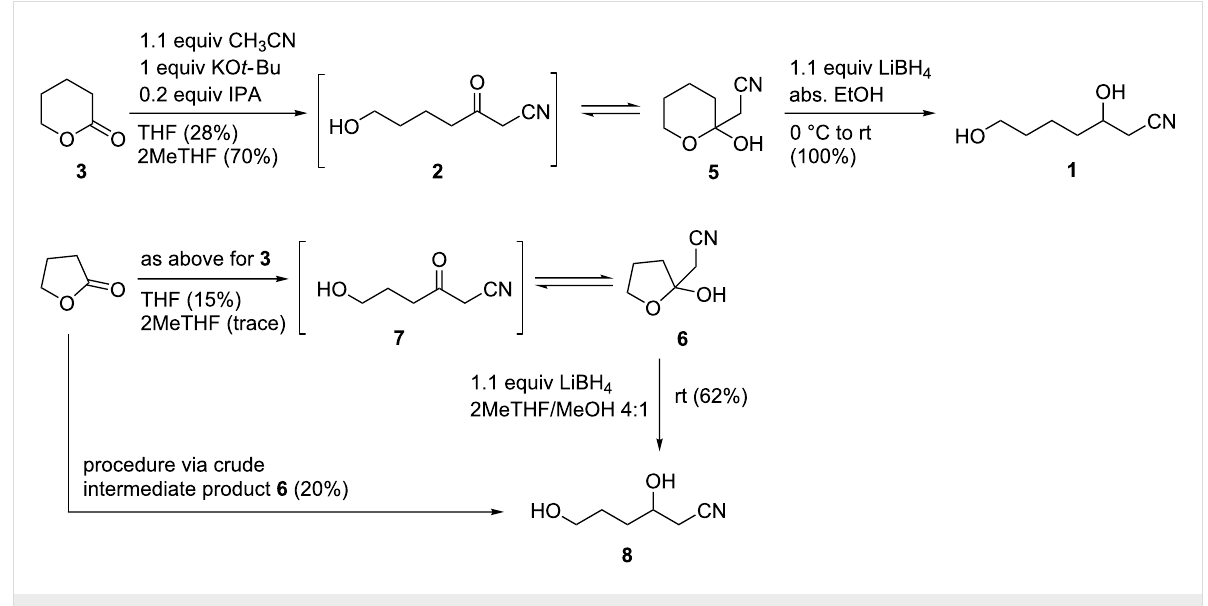
Scheme 2: Preparation of O -unprotected, trifunctionalized synthons from lactones.